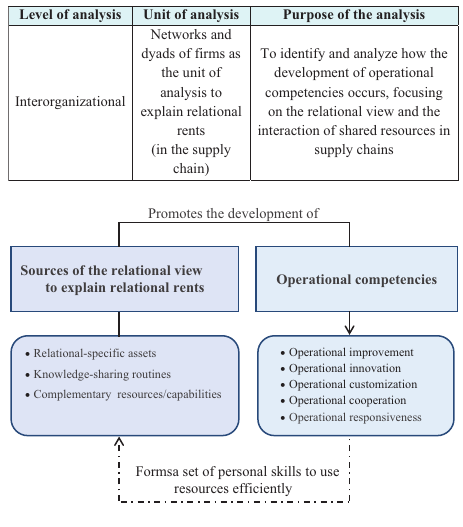
Figure 1. Research